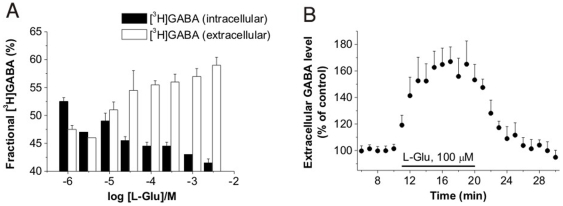
Glu induces GABA release (A) Glu uptake decreases cytosolic GABA level as determined by [3H]GABA release from NPMV vesicles preloaded with [3H]GABA (n = 3).IC50 value for Glu: 13.1±1.6 µM. (B) Elevation of [GABA]o in acute rat hippocampal slices during application of 100 µM Glu (n = 6; 149±14% of pre-stimulus control).